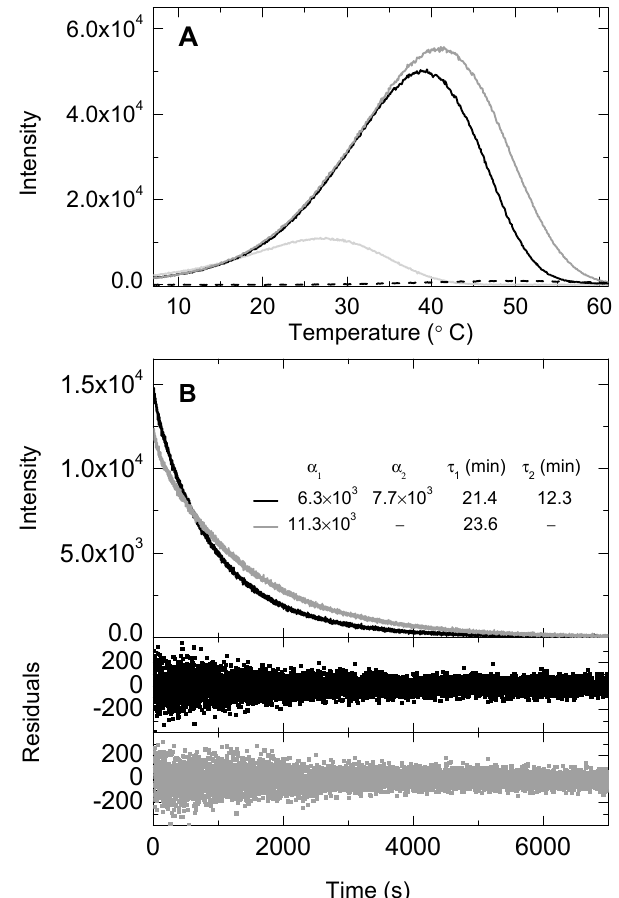
Figure 5. Temperature ( A ) and time dependence ( B ) of the chemiluminescence traces of the Singlet Oxygen Chemiluminescence (SOCL) phenoxy-dioxetane derivative after the photo-oxygenation reaction of SOCL with 1 O 2 in the presence of bovine serum albumin (0 mg mL − 1 , solid light grey line; 3 mg mL − 1 , solid black line; 6 mg mL − 1 , solid dark grey line; and 6 mg mL − 1 without SOCL addition, dashed black line) in phosphate bu ff er saline pH 7.4. Before monitoring the chemiluminescence traces, the reaction mixtures were set in the oxygen electrode chamber under atmospheric pressure conditions, where 2 µ M methylene blue was present as 1 O 2 photosensitizer and 0.5 mM SOCL as 1 O 2 quencher. The reaction mixtures were illuminated with a red light emitting diode source with an intensity of 2 mE m − 2 s − 1 for 2 min at 20 ◦ C. For the temperature ramp experiments, samples were taken from the oxygen electrode chamber after illumination and cooled down in a 1 cm fluorescence cuvette for 2 min to reach a temperature of 6 ◦ C before monitoring the chemiluminescence traces. For the time-based experiments, samples were taken from the oxygen electrode chamber after illumination and placed in a 1 cm fluorescence cuvette pre-incubated at 20 ◦ C. The data was fitted to a bi-exponential equation, I 515nm = α 0 + α 1 exp ( − t / τ 1 ) + α 2 exp ( − t / τ 2 ). Also shown are the corresponding residuals for each temperature experiment. The standard errors for the decay rate constants are <5%.